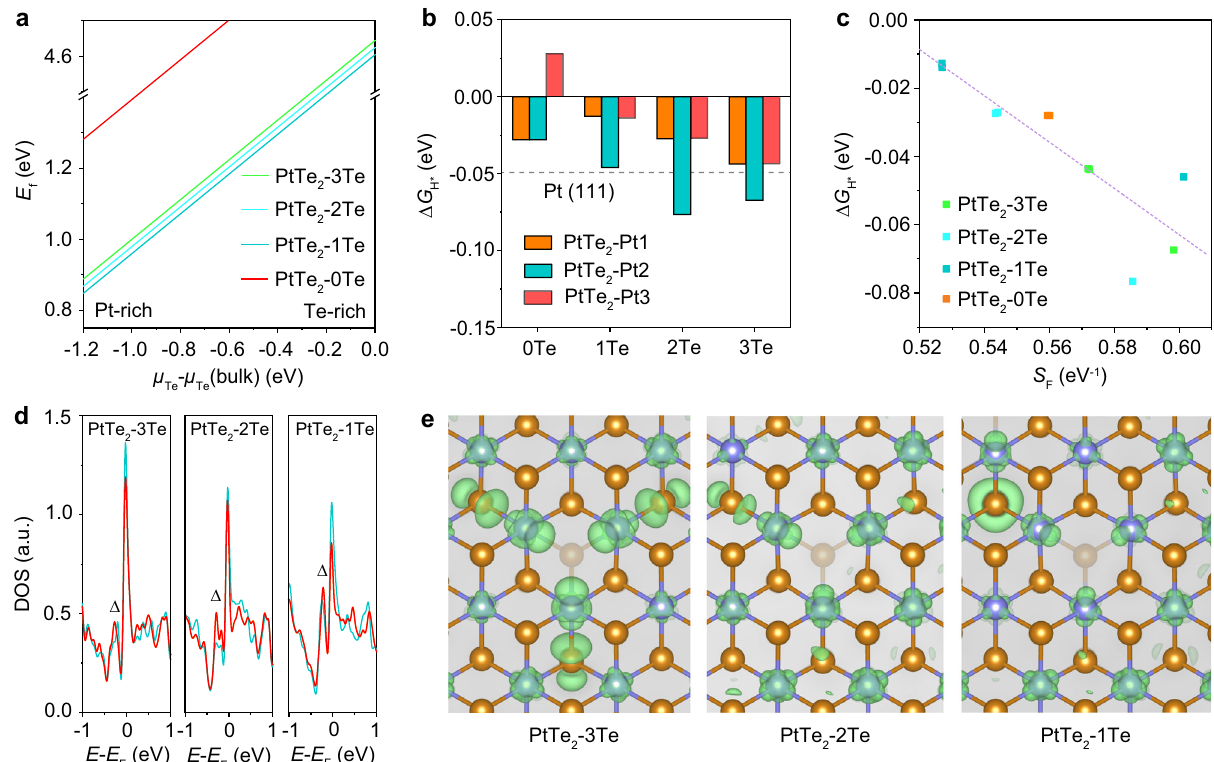
Fig. 4 Electronic structure and binding strength of H. a Formation energy of bilayer PtTe 2 -3Te, PtTe 2 -2Te, PtTe 2 -1Te, and PtTe 2 -0Te structures. b The calculated hydrogen adsorption free energy of different undercoordinated Pt sites in PtTe 2 . c Dependence of hydrogen adsorption free energy on Fermi softness of Pt sites in various PtTe 2 structures. The nominal electronic temperature in weight function was set to 0.1. d DOS curves of Pt sites in PtTe 2 -3Te, PtTe 2 -2Te, and PtTe 2 -1Te structures. The orange, blue, and red lines represent the DOS of Pt1, Pt2, and Pt3 sites in the corresponding PtTe 2 -XTe structure, respectively. e The corresponding partial charge. The isosurface level was set to 0.002 e Å − 3